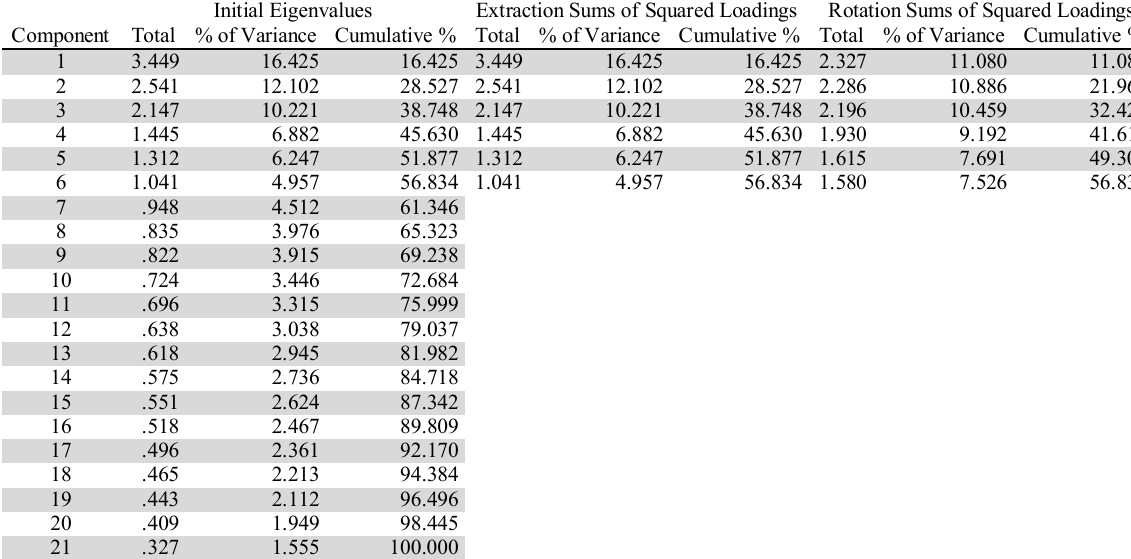
The summary of principal component analysis after rotation